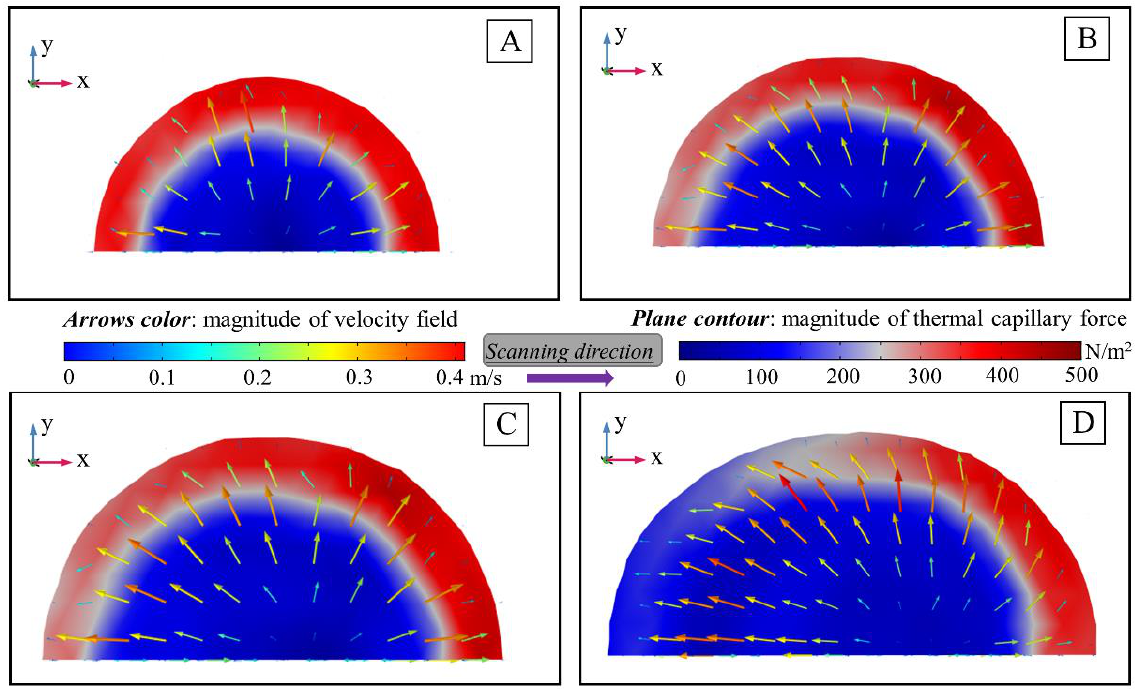
Figure 6. Thermal capillary force distribution at top surface of the melt pool at different times: ( A )10 ms; ( B ) 50 ms; ( C ) 100 ms; ( D ) 200 ms.